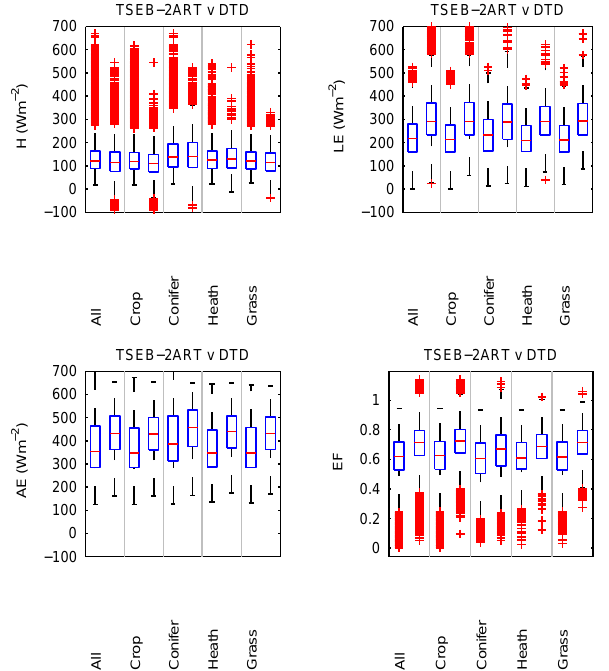
Figure 10. Box plots of sensible heat flux (top left), latent heat flux (top right), net radiation (bottom left) and evaporative frac- tion (bottom right) modelled by TSEB-2ART (leftward box in each category) and DTD (rightward box in each category) and split by land cover class. The red horizontal line indicates the median value with the upper and lower box edges indicating the 75th and 25th percentiles respectively. The whiskers extend to the furthest point within 1.5 times the inter-box range above or bellow the box edges with points beyond that categorized as outliers and marked individ- ually as a red